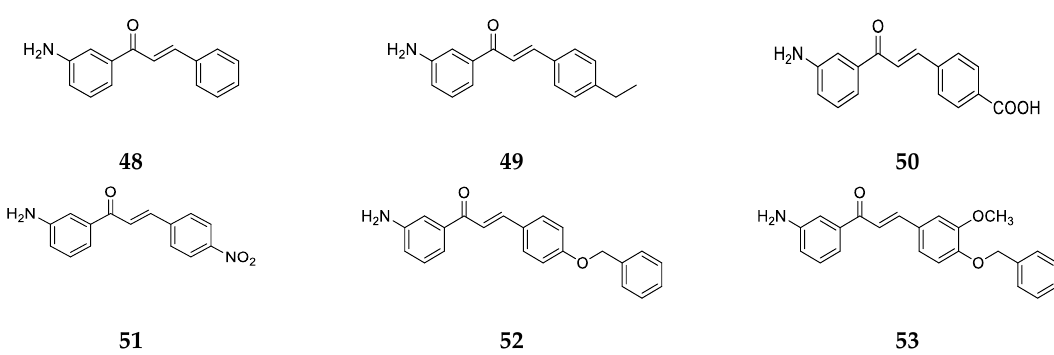
Figure 30. Chemical structures of 3-aminochalcone derivatives with substitution on ring B.